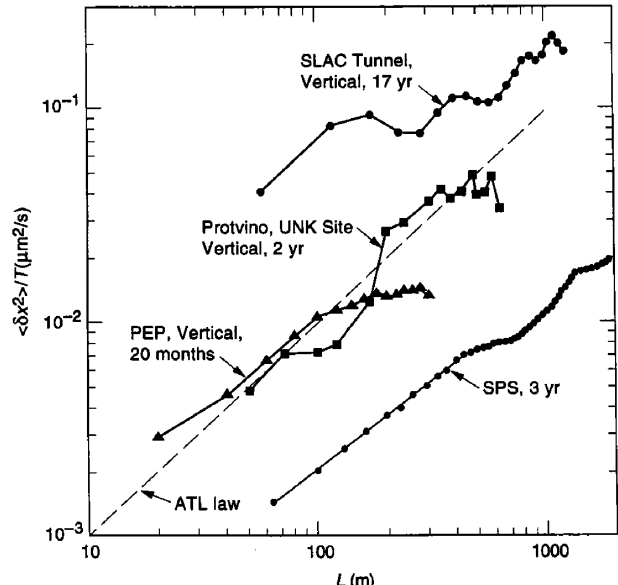
FIG. 20. Variances of the accelerator magnet displacements per unit time vs distance for the SLC, UNK, PEP, and SLAC tunnel (see text, from Ref.